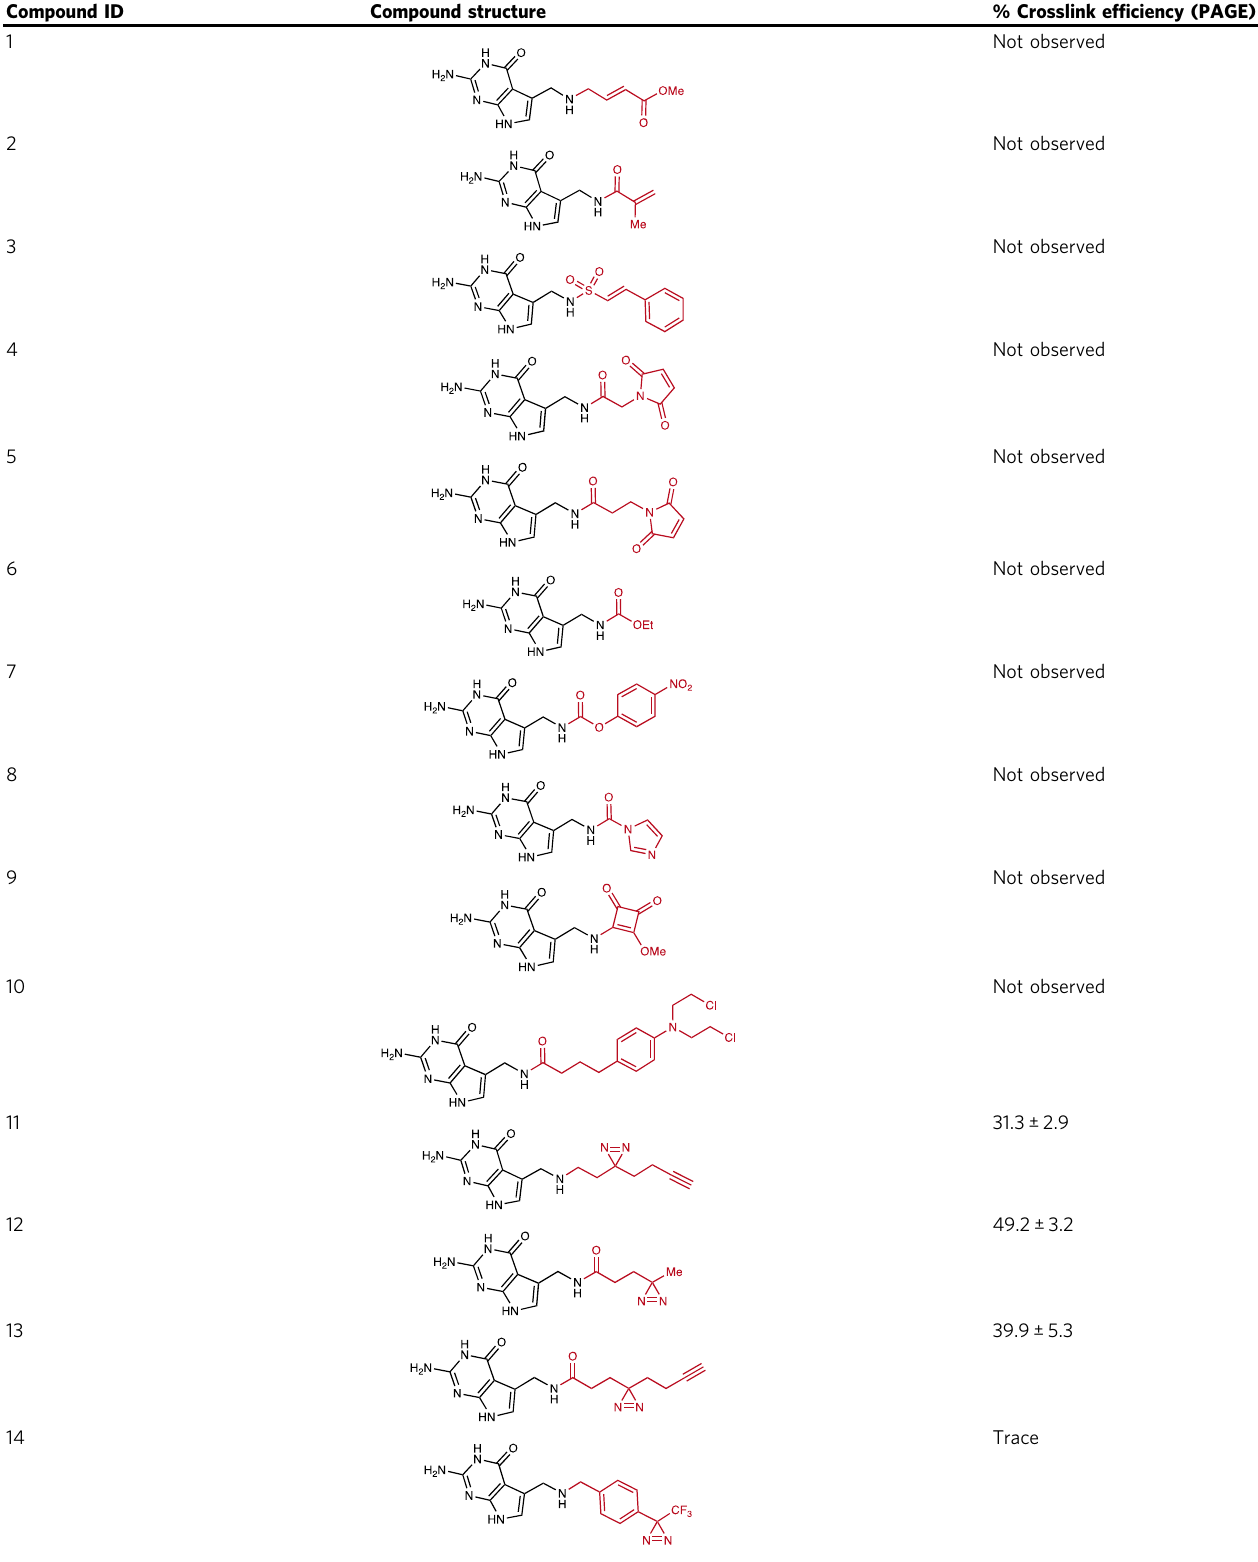
Table 1 Structures and crosslinking ef fi ciencies for electrophilic and photoaf fi nity probes used for proximity induced